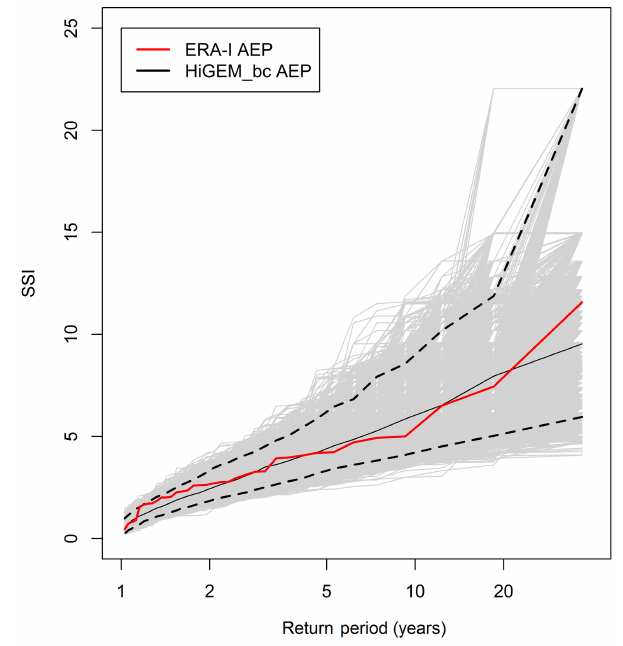
Figure 5. Return periods of AEP for ERA-Interim (red line). The light grey lines are the 10000 bootstrap samples of the HiGEM_bc AEP. The black dashed lines are the associated 95% confidence intervals of the HiGEM_bc AEP and the black solid line is the me- dian.